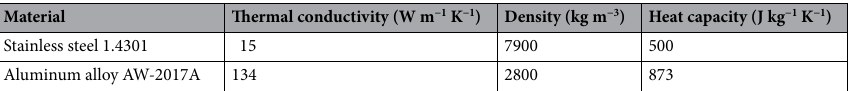
Table 2. Material